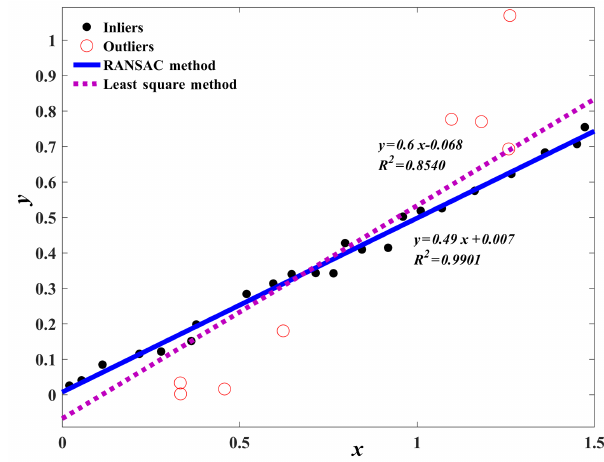
Figure 1. Comparison of the fitted lines obtained from the RANSAC algorithm and the least squares